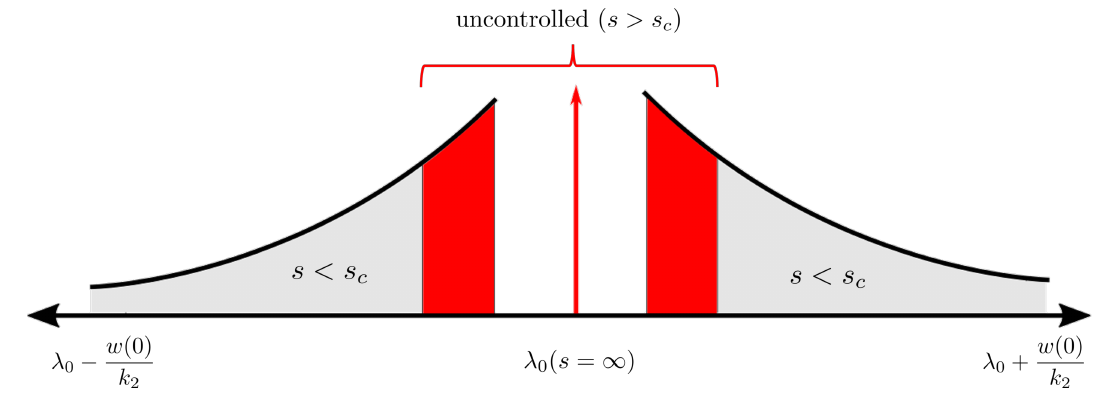
Figure 7 . A rough sketch (not to scale) of the negativity spectrum near the cyclic-to-pairwise